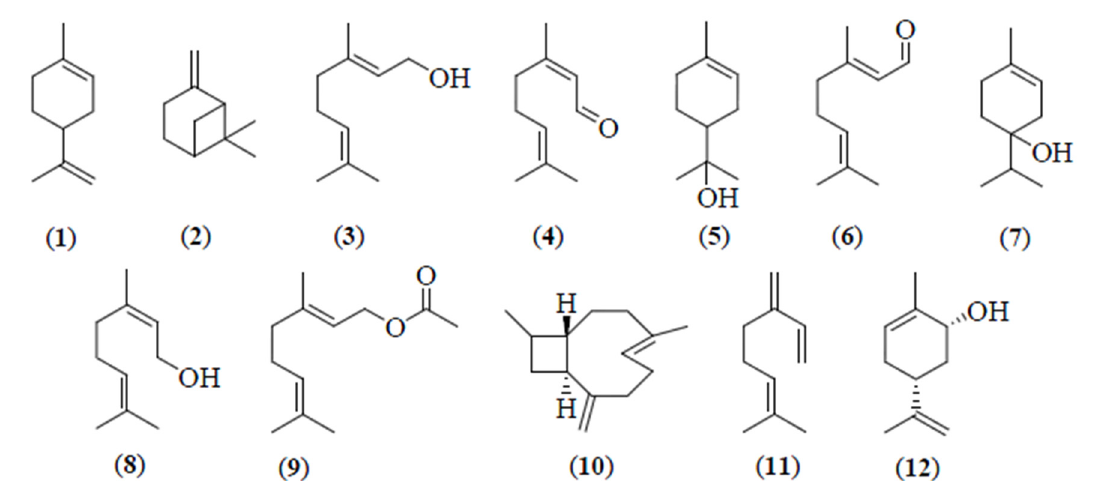
Figure 3. C hemical structures of the components identified from the Citrus essential oils. 2.3. Citrus hystrix Citrus hystrix (synonym: kaffir lime) (Figure 4) is known as ‘limau purut’ or ‘wild lime’. C. hystrix leaves and fruits are widely used as spices in preparation of ‘tomyam’, either white or red, and it is famous dish in Malaysia and Thailand [22]. The height of this plant is about 3–5 m and the fragrant green leaves are 7.5–10 cm long. It has white flowers with 4–6 petals. The diameter of pear ‐ shaped fruits is about 5.0–7.5 cm with wrinkle on the surface of fruit. The fruit is dark green, and yellow when ripe [23]. The essential oil of C. hystrix is used in aromatherapy and an essential ingredient of various cosmetic and beauty products [20]. In traditional medicine, C. hystrix is used to treat flu, fever, hypertension, abdominal pains, and diarrhea in infants [24]. The fruits are used as a digestive stimulant, blood purifier, and reduce high blood pressure [25,26]. Additionally, the fruits are used in cooking for flavoring and also in the production of shampoo as an insecticide for washing the head [27]. In addition, the fruit juice is used in softening the skin and the mixture of the fruit juice with bath water can be used to eliminate body